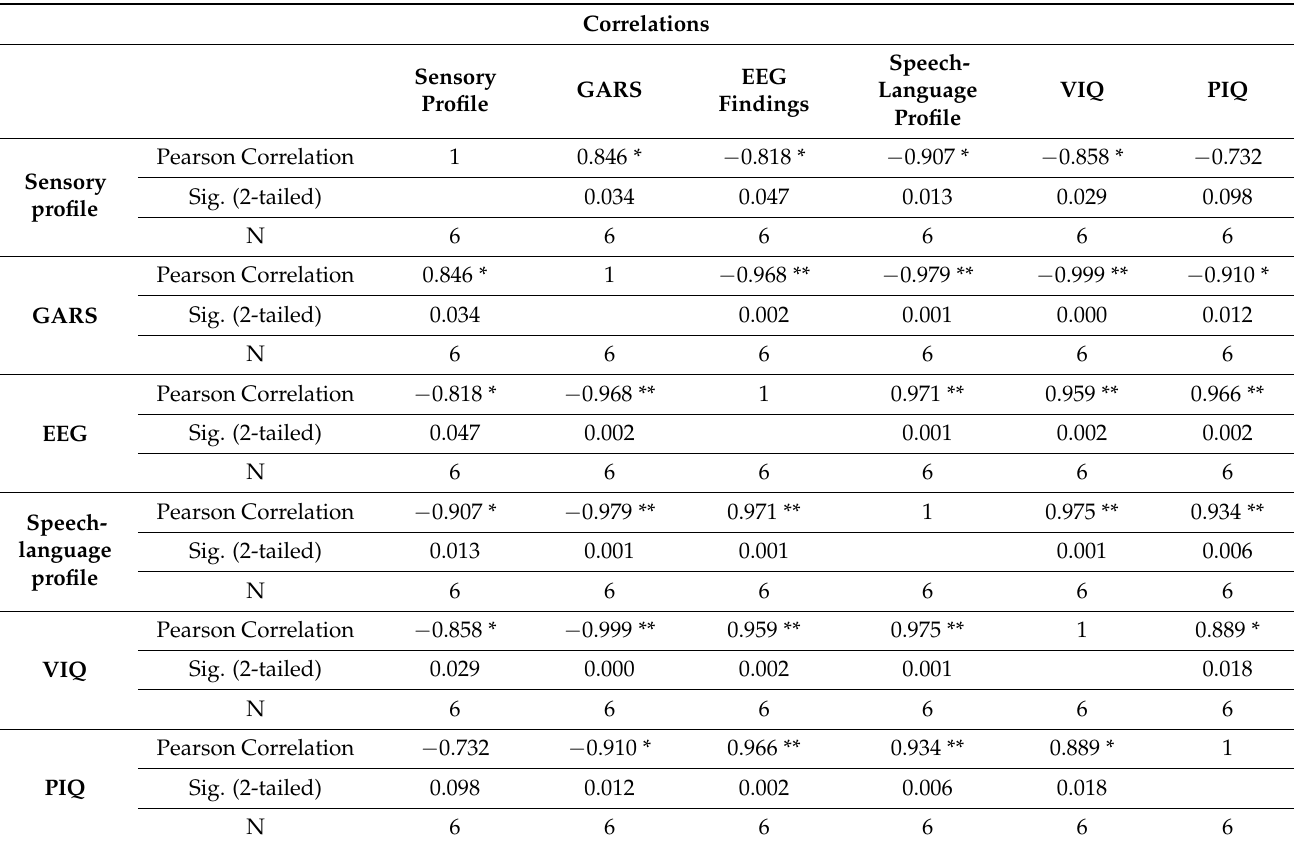
Table 6. Pearson correlation and obtained statistical significance between normalized test